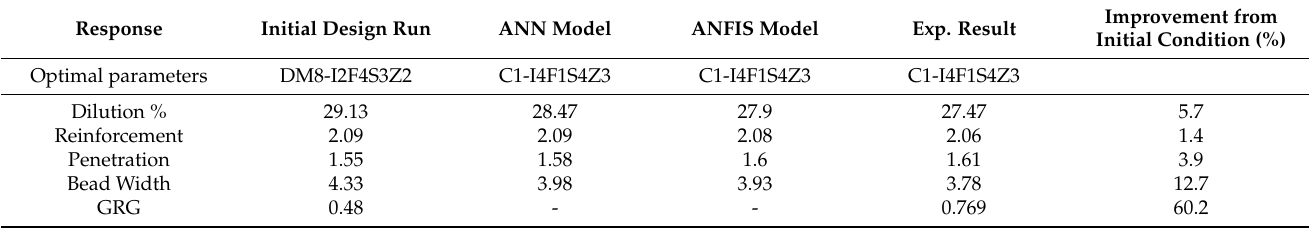
Table 11. Confirmatory test results and